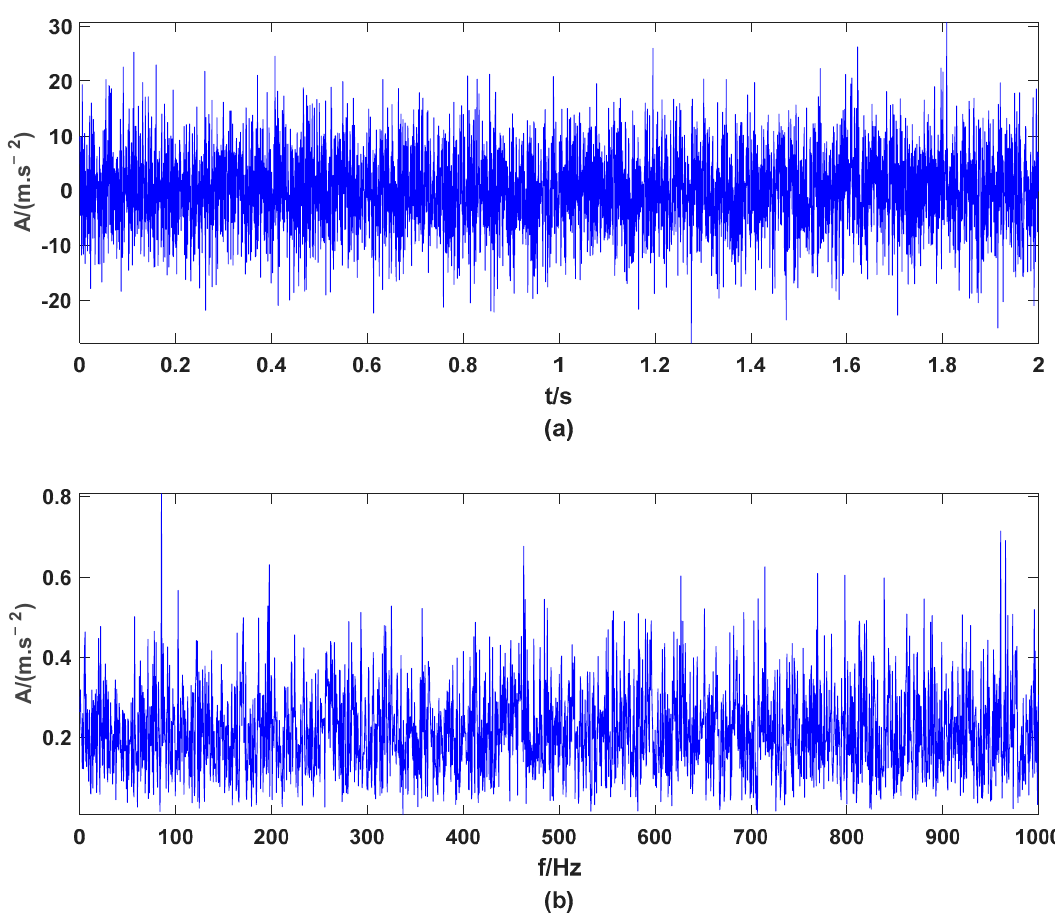
Figure 3. S imulation signal ( a ) time domain curve ( b ) frequency domain curve. Figure 3. Simulation signal ( a ) time domain curve ( b ) frequency domain